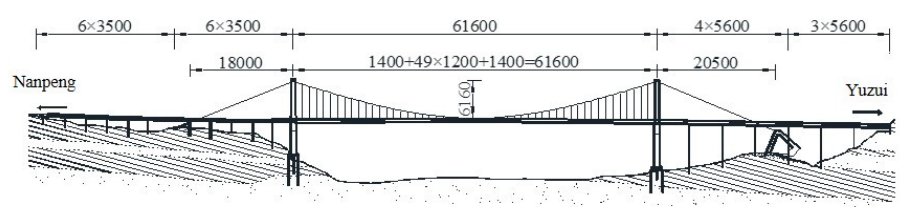
Figure 7. General arrangement of the bridge [35].